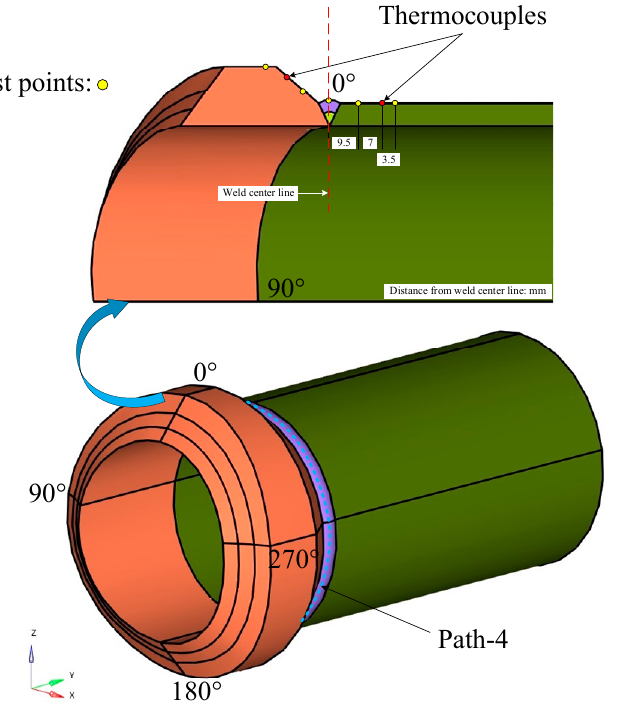
Figure 3. Three-dimensional (3D) model of the weldolet and branch Figure 3. Three ‐ dimensional (3D) model of the weldolet and branch pipe.